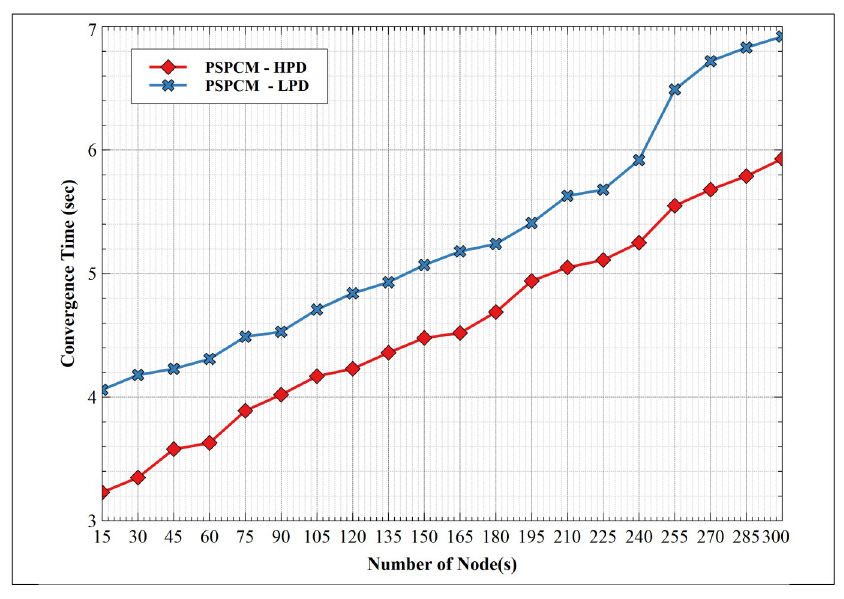
Fig 15. Convergence time—HPD vs LPD.